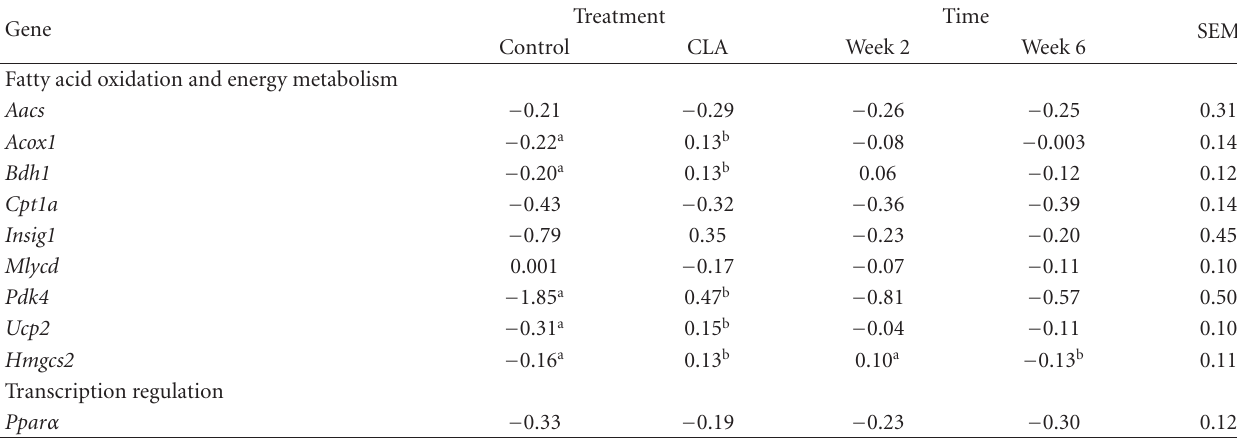
Table 5: Hepatic expression of genes related to lipid catabolism in mice fed control or the control supplemented with trans -10, cis -12-CLA (CLA). There were no significant interactions of treatment × time. Therefore, the results are presented according to main e ff ects (treatment and time).